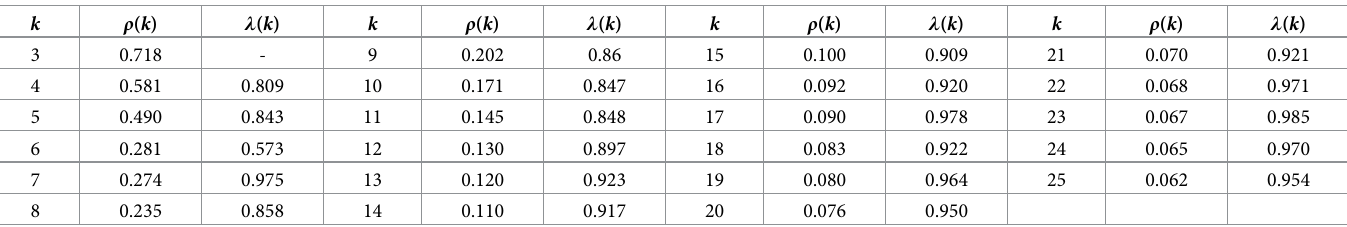
Table 4. The values of ρ ( k ) and λ ( k ) from Equation (16) and Definition 7. k ρ ( k ) λ ( k